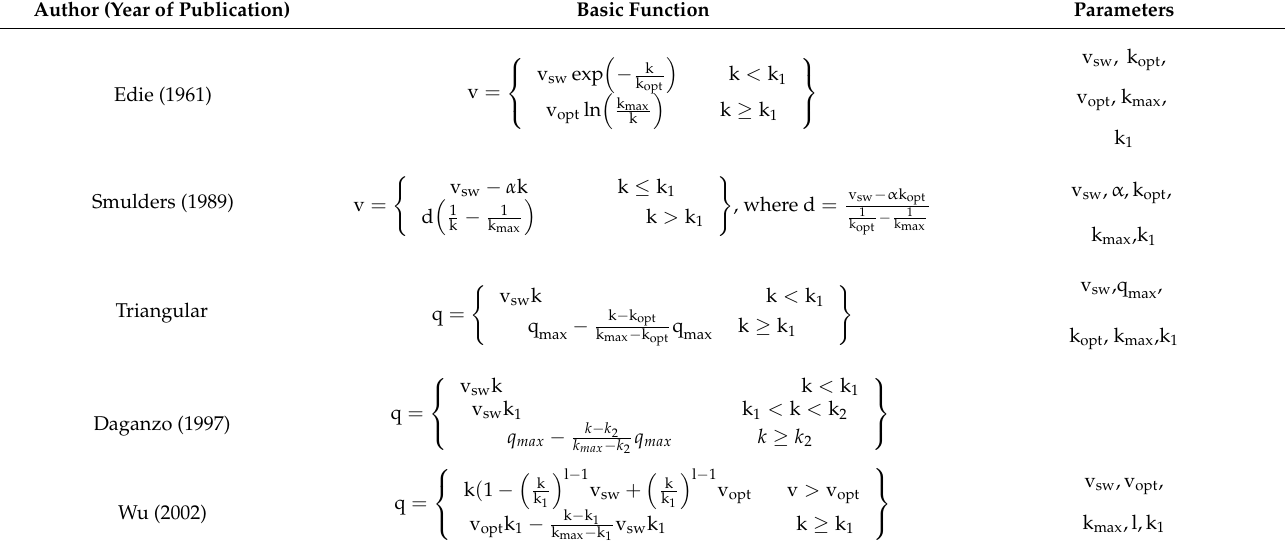
Table 2. List of selected multi-regime